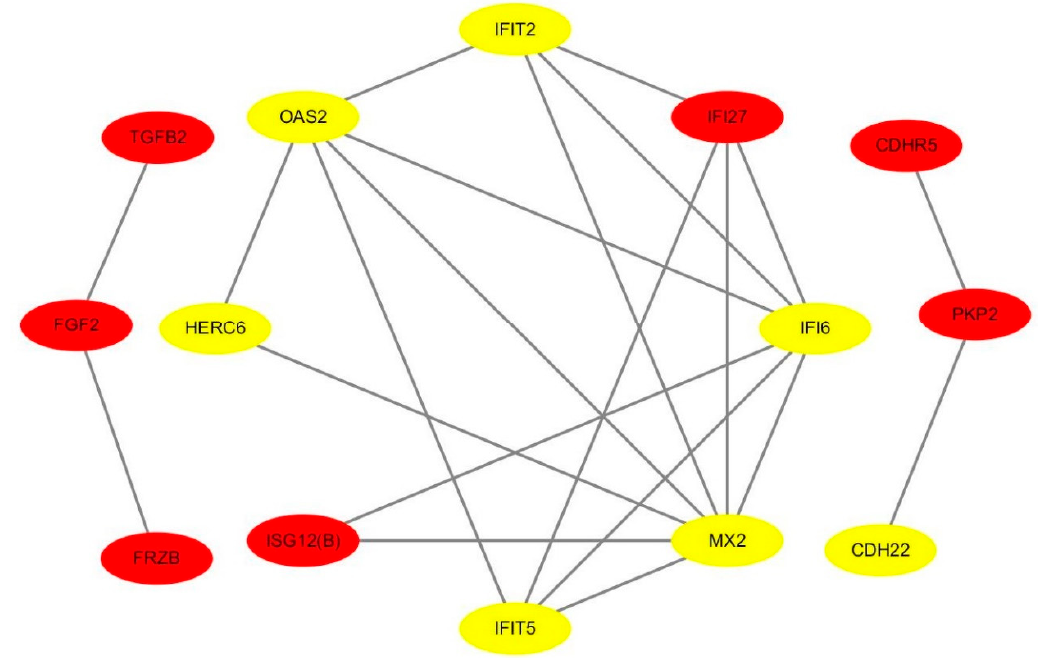
Figure 4. A protein–protein interaction (PPI) network of hub genes regarding heat stress. Yellow and red marker genes represent up- and down-regulated genes, respectively.